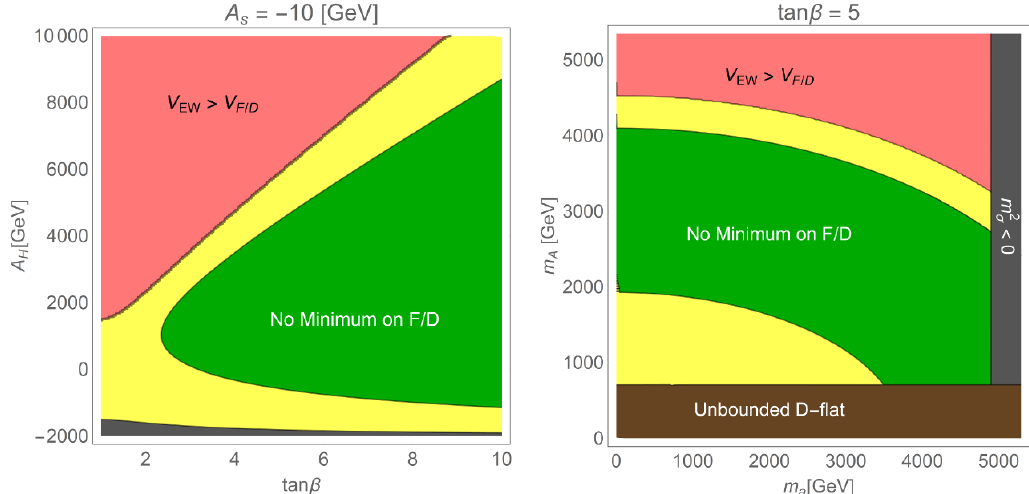
Figure 1 . Parameter space where the EW minimum is deeper than the other minimum. (cid:15)v s = 1 : 0 TeV and c N = c m = 1. The green and yellow region have the stable EW